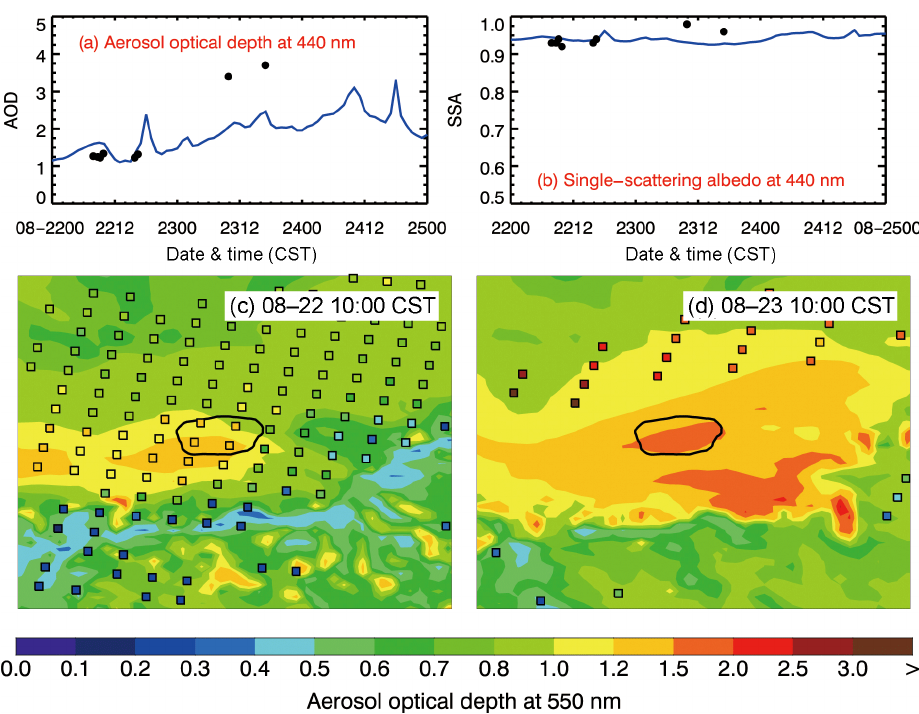
Figure 14. Retrieved (black dots) and calculated (blue lines) diurnal profiles of (a) AOD and (b) aerosol SSA at 440nm at the IEECAS site from 22 to 24 August 2013 and pattern comparison of calculated vs. retrieved AOD at 550nm at 10:00CST on (c) 22 August and (d) 23 August 2013. Colored squares: retrieved AOD; color contour: calculated AOD.